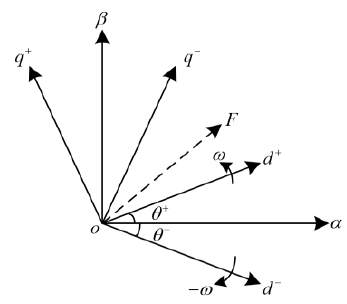
Figure 2. Vector diagram of the positive and negative synchronous rotation